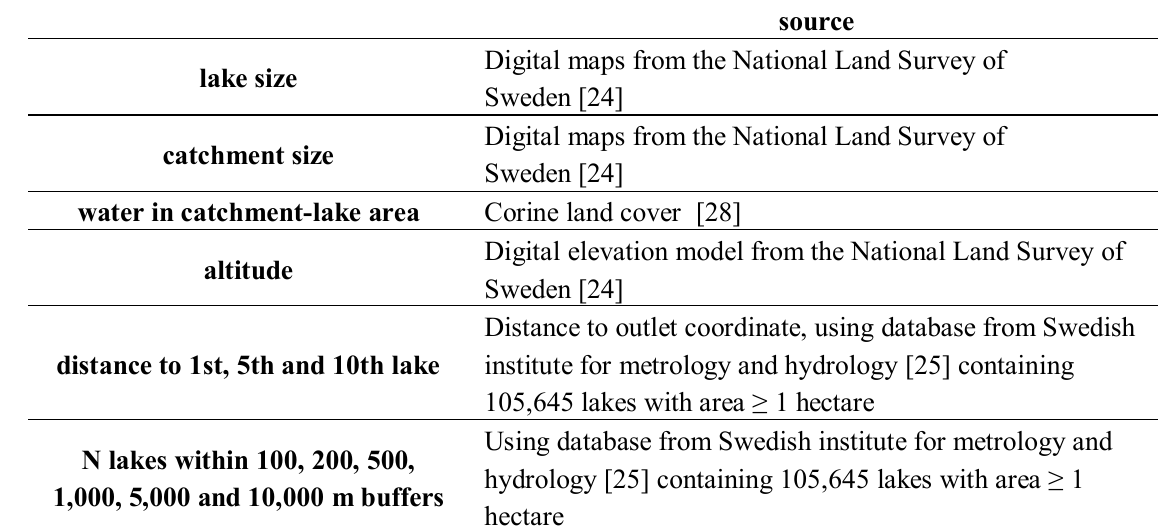
Table 3. Lake characteristics for evaluation of model